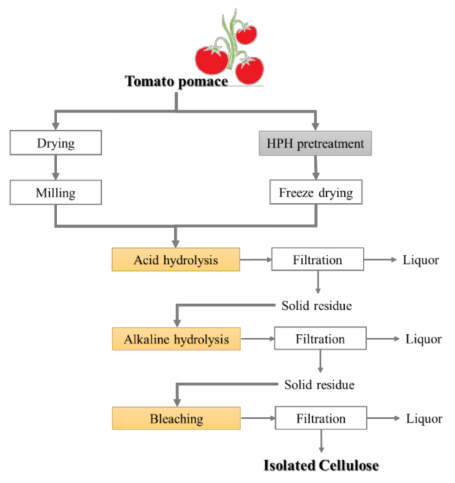
Figure 1. Schematic diagram of the procedures for extracting cellulose from tomato pomace (TP) and from tomato pomace pretreated by HPH